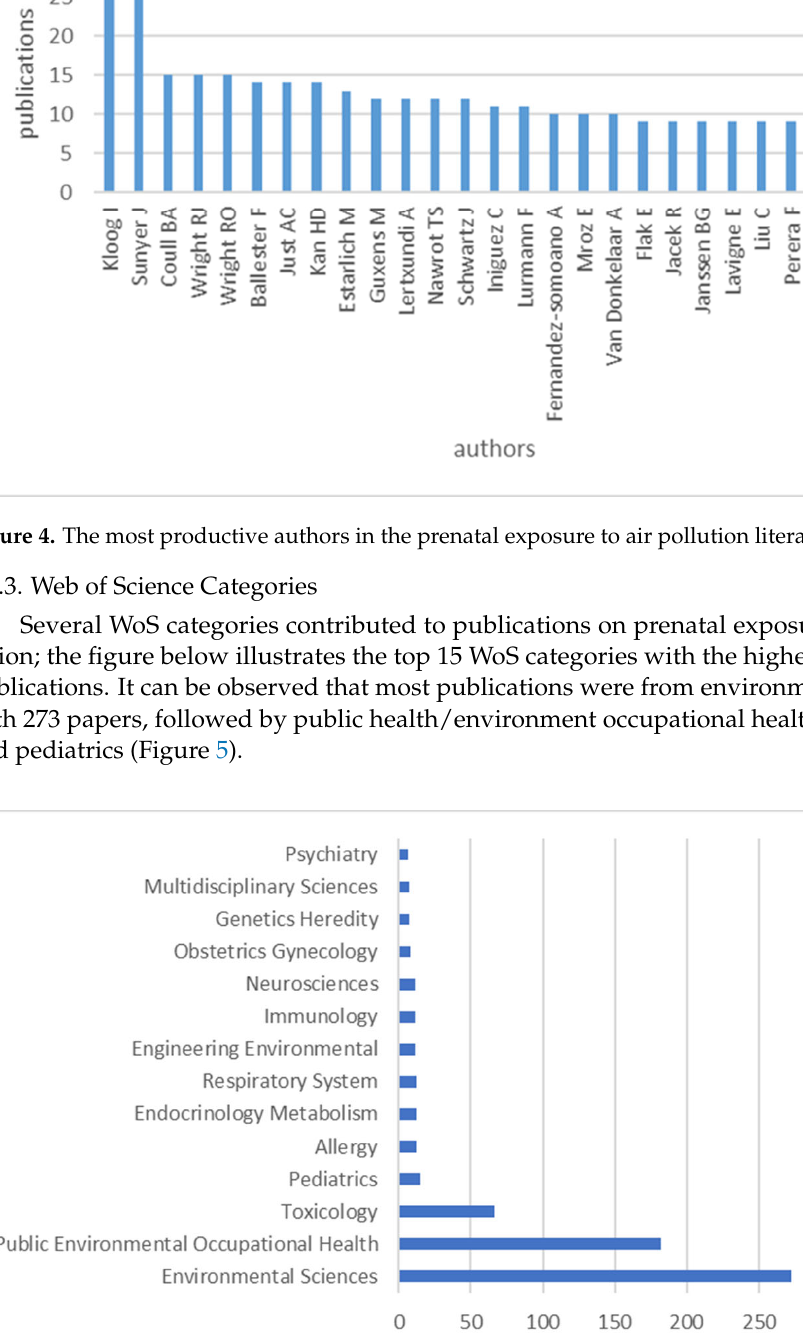
Figure 3. Annual distribution of prenatal exposure to air pollution publications by countries and territories.